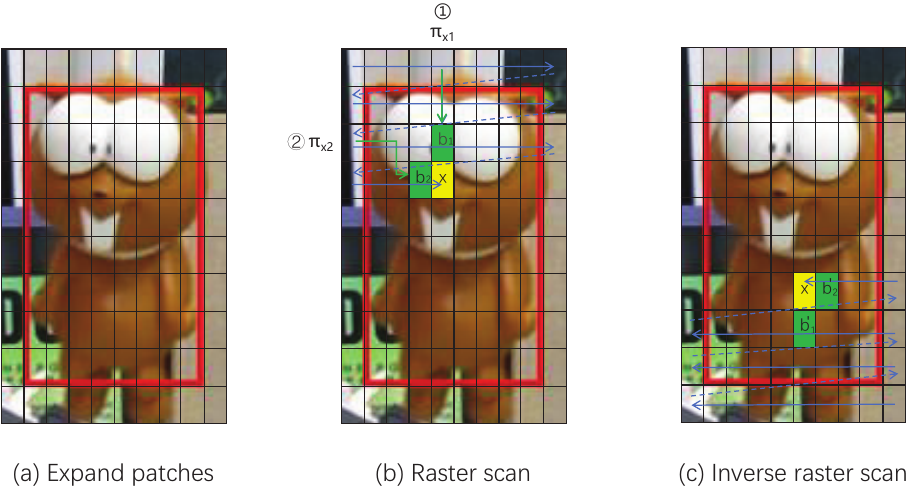
Figure 3. Illustration of the raster scan pass and the inverse raster scan pass. The node x is the current visited patch and its masked neighbor area for 4-adjacency is denoted as